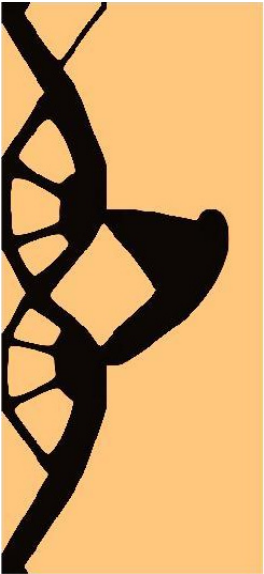
Figure 19. The final topology found for the test structure 4.